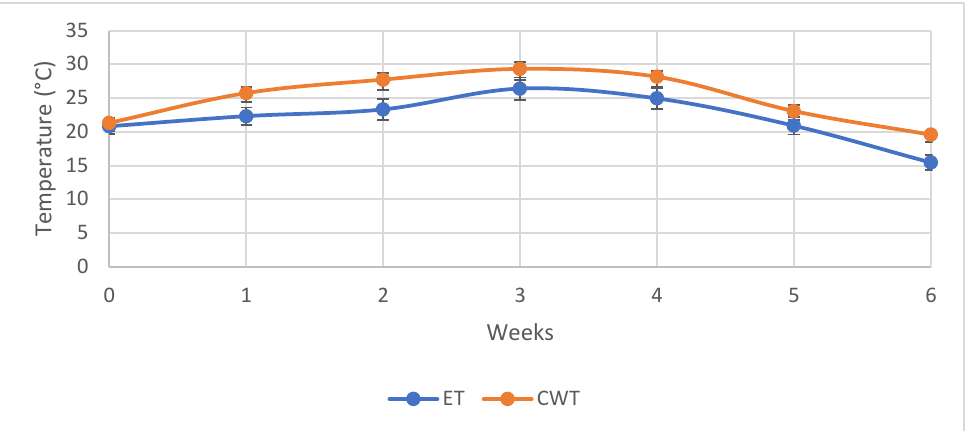
Figure 1. Environmental temperature (ET) and Corn Cob Waste Temperature (CWT) behavior in pre-composting.